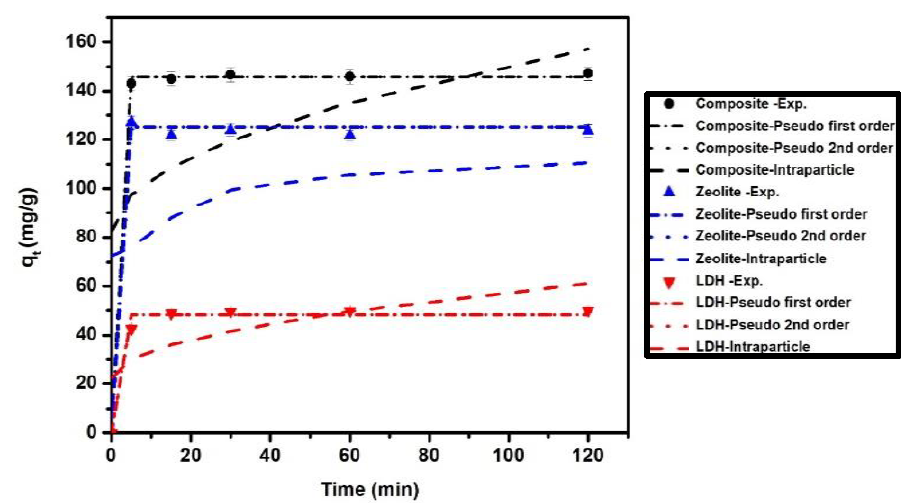
Figure 10. Comparison of adsorption kinetics models with experimental data of MB dye on LDH, zeolite and composite at concentrations 100 mg/L.